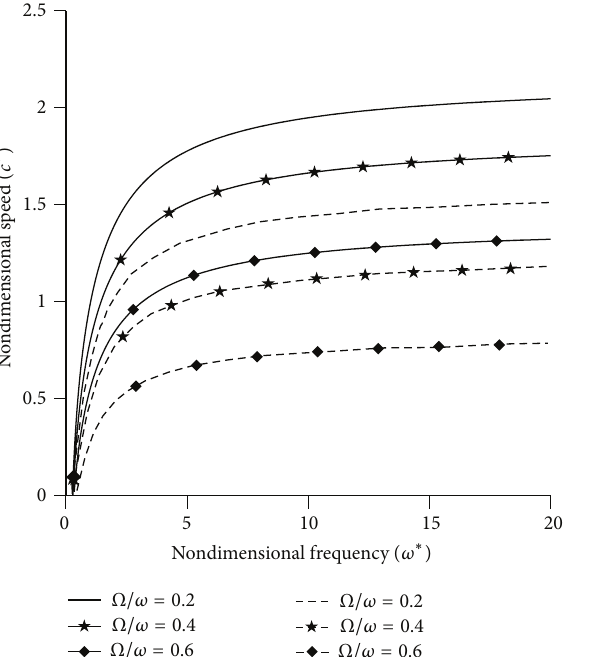
Figure 2: Variations of the non-dimensional speed of Rayleigh wave against non-dimensional frequency 𝜔 ∗ (solid lines:orthotropic micropolar elastic case, dotted lines:isotropic micropolar elastic